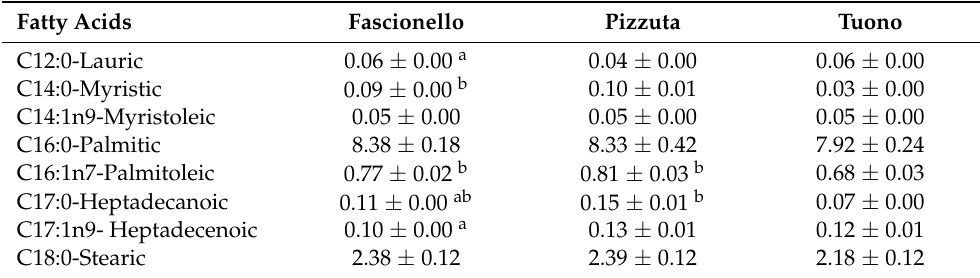
Table 2. Characterization of the fatty acids profiles by GC–FID and GC–MS analyses of blanched skin samples belonging to three different almonds’ cultivars: Fascionello, Pizzuta, and Tuono. For the Fascionello and Pizzuta cultivars, the average data of the six producers were reported. The results, expressed as percentage (%) of the total fatty acids identified and quantified, represent the mean ± standard deviation of three independent experiments in triplicate ( n =